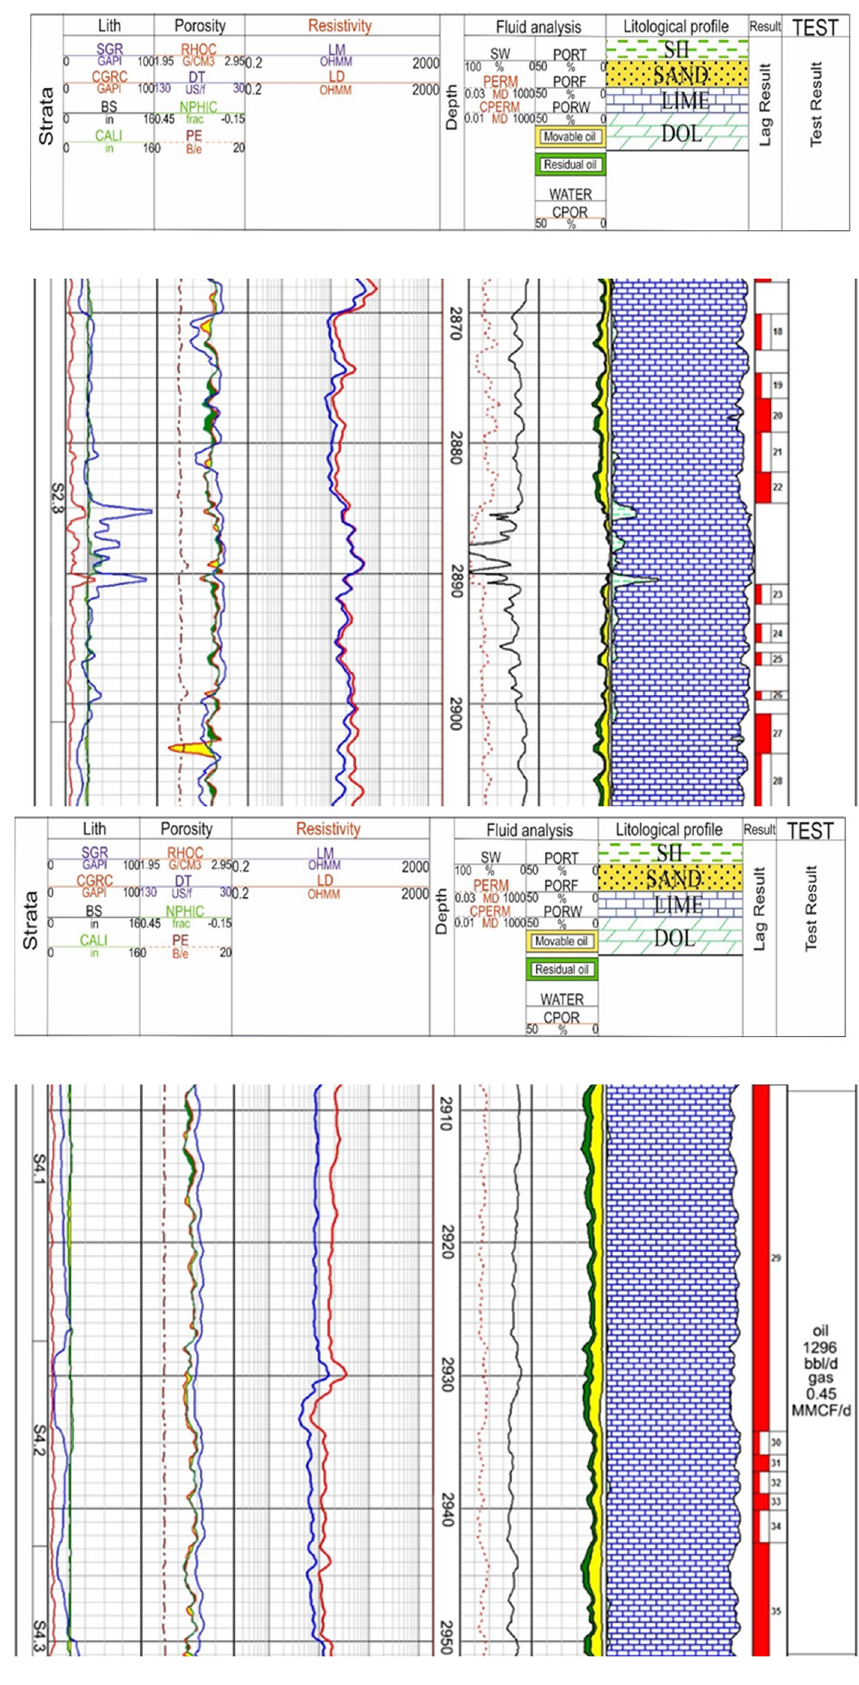
Fig. 16 Composite well log for